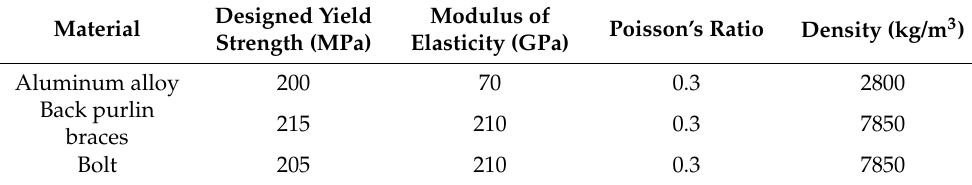
Figure 7. Schematic diagram of joint formwork installation. Table 4. Mechanical properties and density of materials for formwork and components.